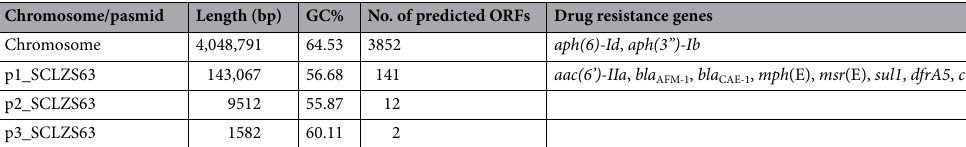
Table 1. Summary of the genetic features of C. aquatica SCLZS63. –, not available.